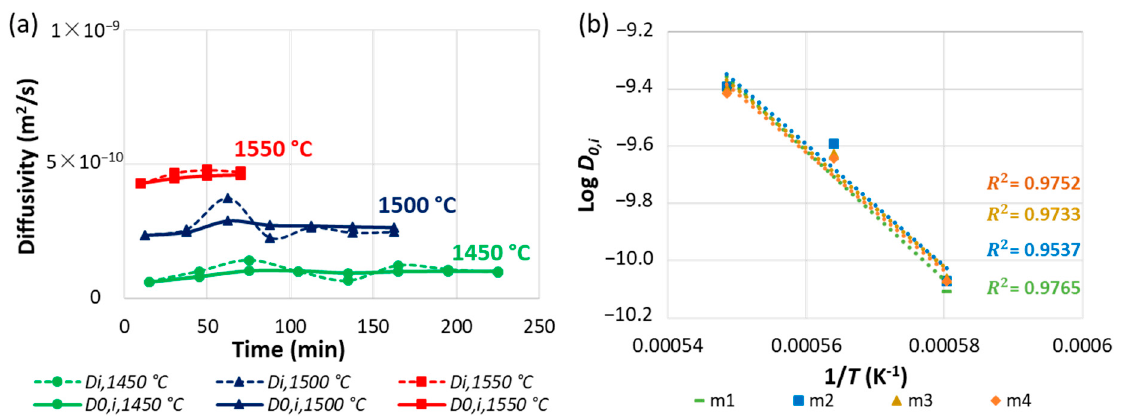
Figure 5. ( a ) Magnesia diffusivity and ( b ) Arrhenius plot of the magnesia diffusivity at 1450, 1500, and 1550 °C. Table 3. Test intervals applied for the Arrhenius plot with the associated mass loss, bulk concentra- tions of magnesia, and the corresponding activation energies for magnesia.